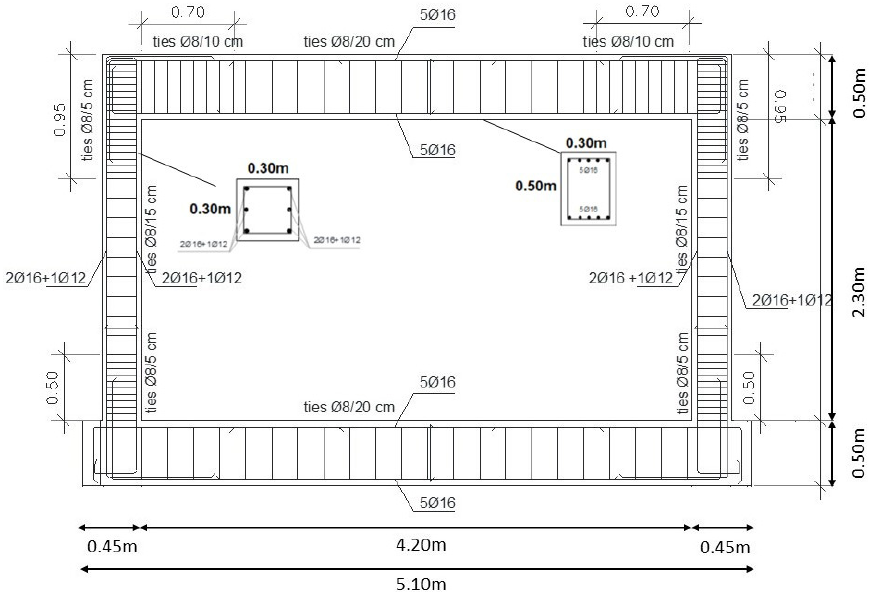
Figure 1. Modeling strategy adopted for the masonry infill walls: ( a ) under compression; and ( b ) under shear.